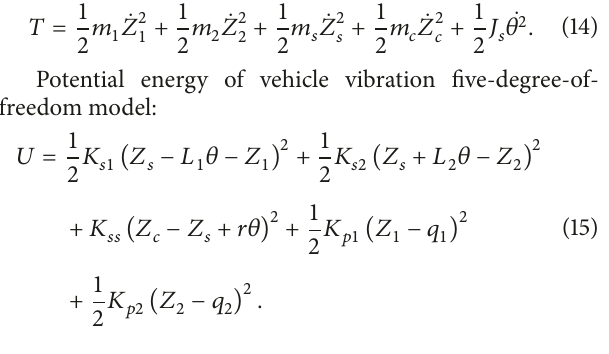
Figure 12: Nondominated solutions with MDPL-MOPSO and CD-MOPSO on ZDT6.